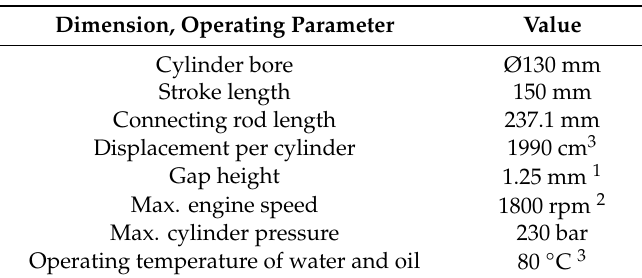
Table 1. Engine block data.